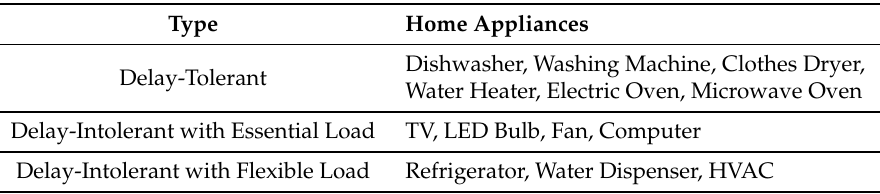
Table 1. Classification of home